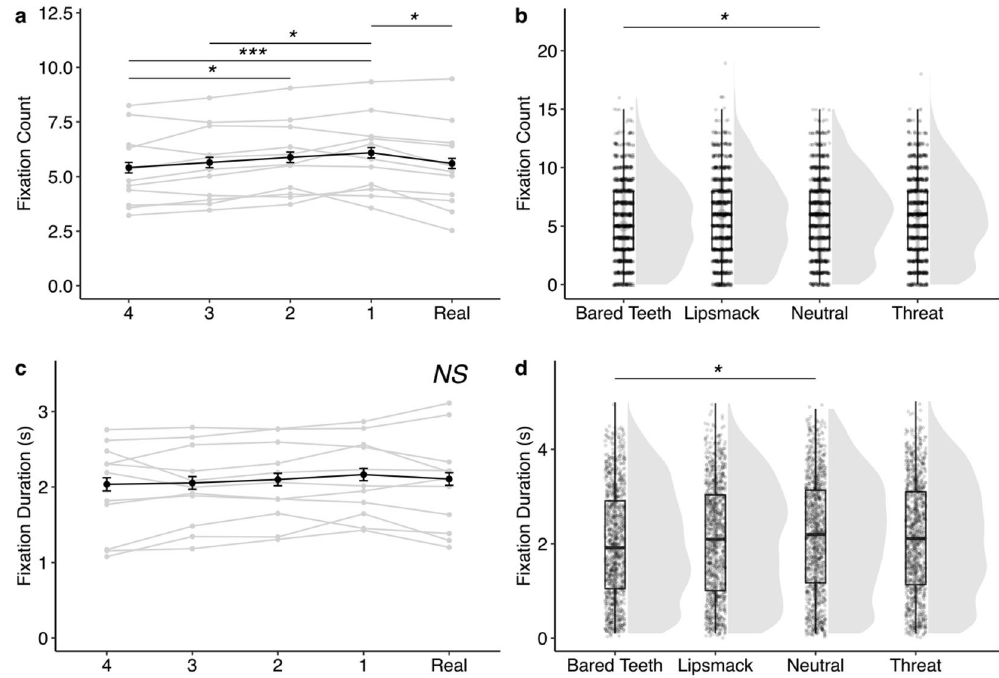
Figure 3. Visual attention directed to the screen but not the face. Fixation count data are in top panels and fixation duration data in bottom panels. In plots on the left ( a , c ), gray lines represent average behavior of a given subject pooled across facial behaviors and the black line represents average behavior across all subjects. In plots on the right ( b , d ), individual data points are overlaid on boxplots with violin plot density functions on the right for each facial behavior pooled across face realness levels. ( a ) Subjects looked outside more times when the stimulus image was the most realistic of the manipulated images Face 1 compared to when it was the Real image ( z = − 3.23, p = 0.011), Face 3 ( z = 2.80, p = 0.041) or the least realistic Face 4 ( z = 4.34, p < 0.001), suggesting that there may be some degree of aversion to the highly realistic Face 1 image. Monkeys also fixated outside